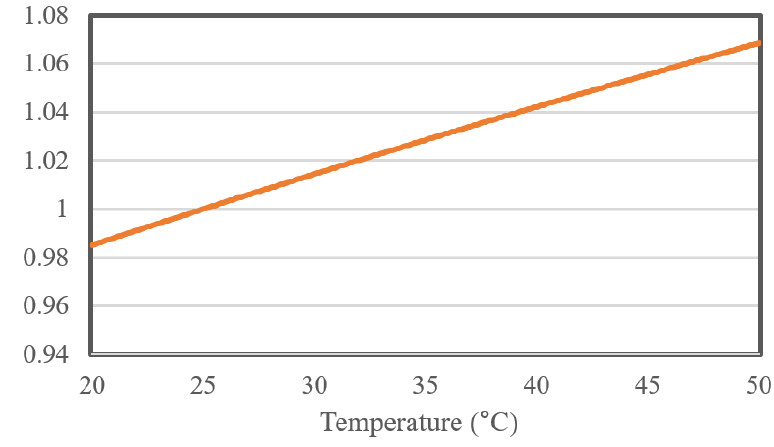
Figure 9. BH as a function of temperature based on the value of 25 °C.